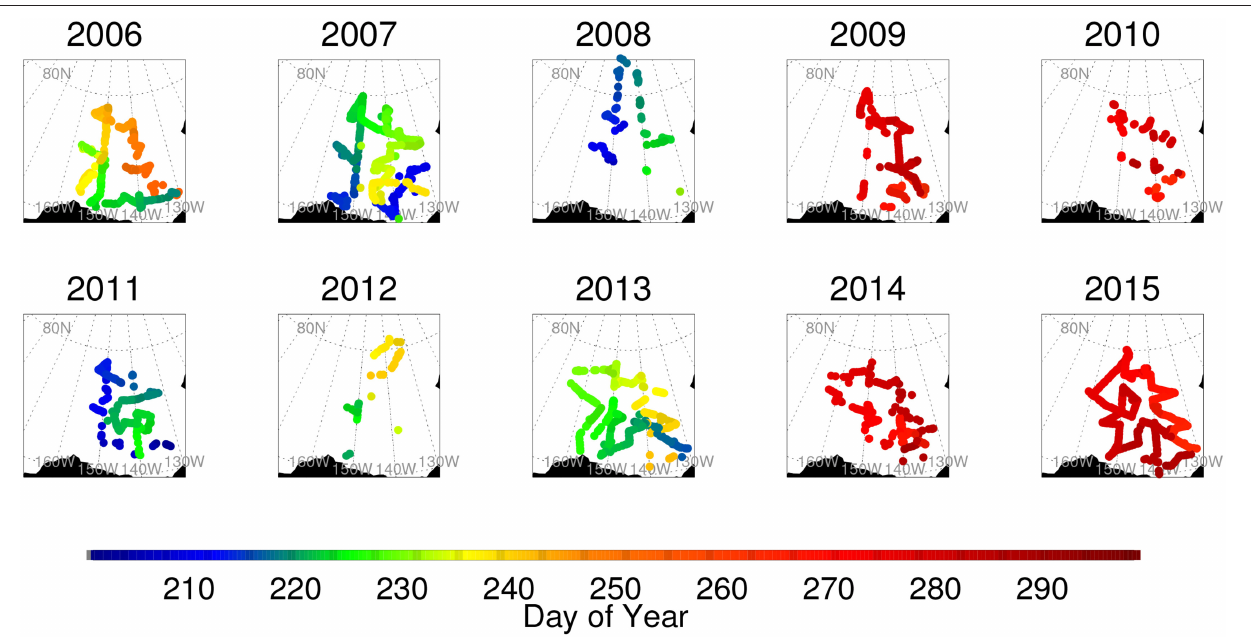
FIGURE 1 | Visual observations of sea ice recorded during JOIS cruises. Color represents the date of the observation. Note that cruises in 2009, 2010, 2014, and 2015 were in late September–October, after the summer minimum ice